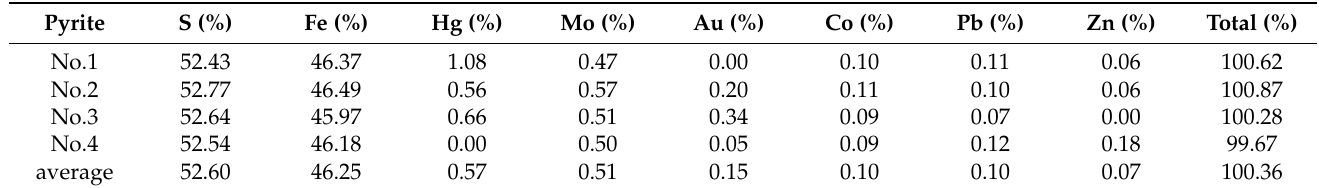
Table 1. Chemical composition of major pyrite analyzed with EPMA